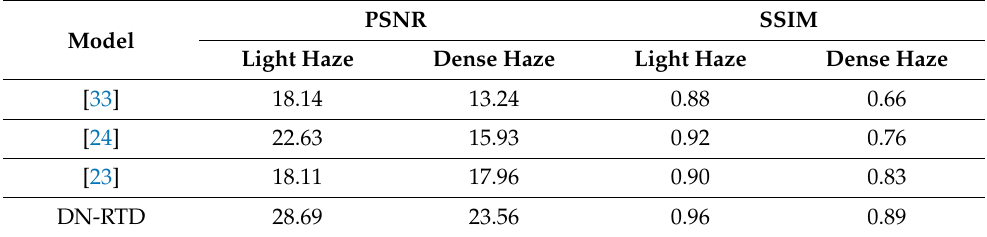
Table 3. Environment identification performance by haze